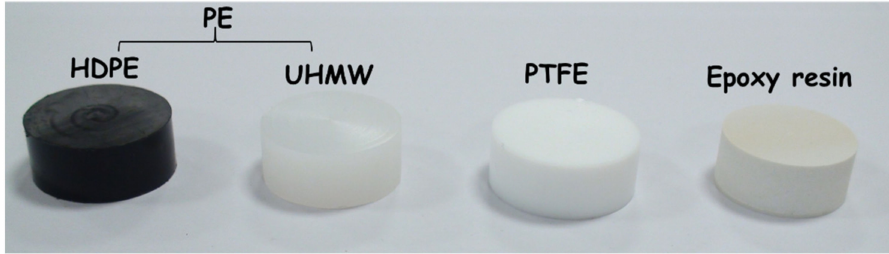
Figure 3. Insulator samples: di ff erent dielectric